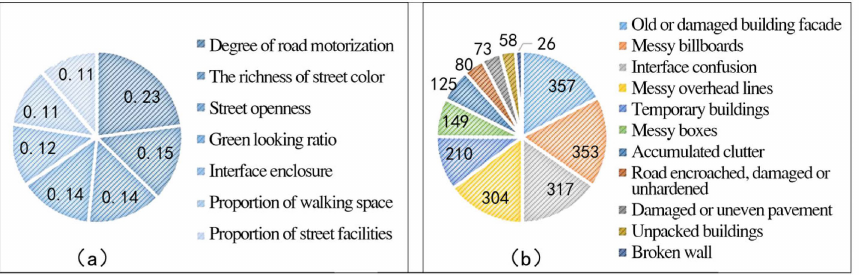
Figure 17. Importance score of the feature elements of secondary trunk roads ( a ) and audit situation of street spatial quality issues ( b ).